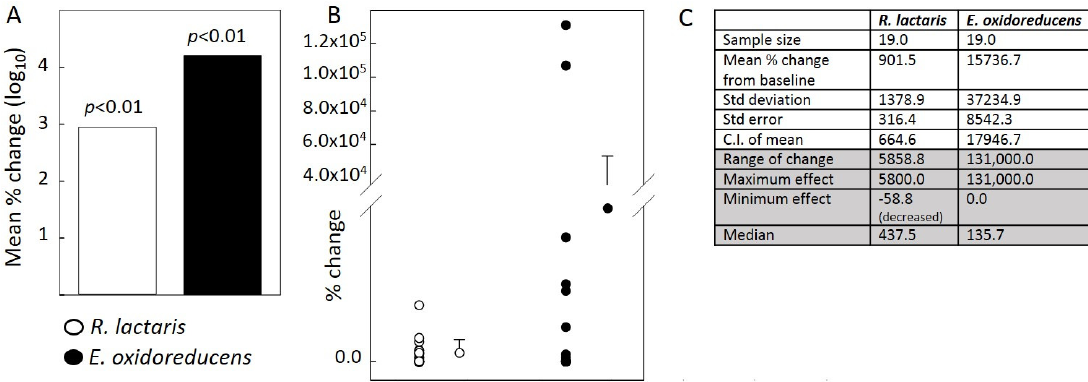
Figure 1. Data presentation formats. ( A ) Relative abundance of two bacterial species before and after RS4 treatment shown as mean % change (log 10 ) with corresponding p values; ( B ) Percent change from before intervention of the same two bacterial species shown as individual data points with means and standard deviations on the side; ( C ) Descriptive statistical information from the two data sets presented in A and B. The information presented in the last four rows are less frequently reported in clinical trial publications.